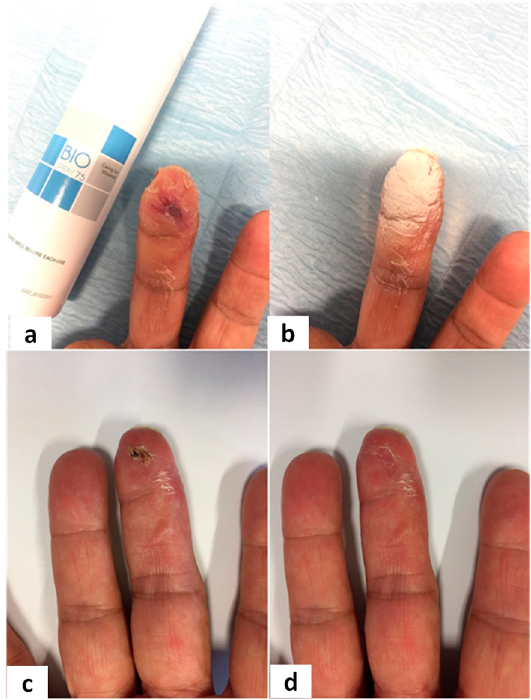
Figure 3. Case Group A. M.F, female 55 y/o affected by diabetes and hypertension reported a post- traumatic chronic wound in the dorsal part of the right arm close to the elbow ( a ). The aspect of the wound at V1 and the application of collagen plates enriched with hyaluronic acid ( b ). The wound aspect at V3 ( c ). The final aspect at V5 ( d ).